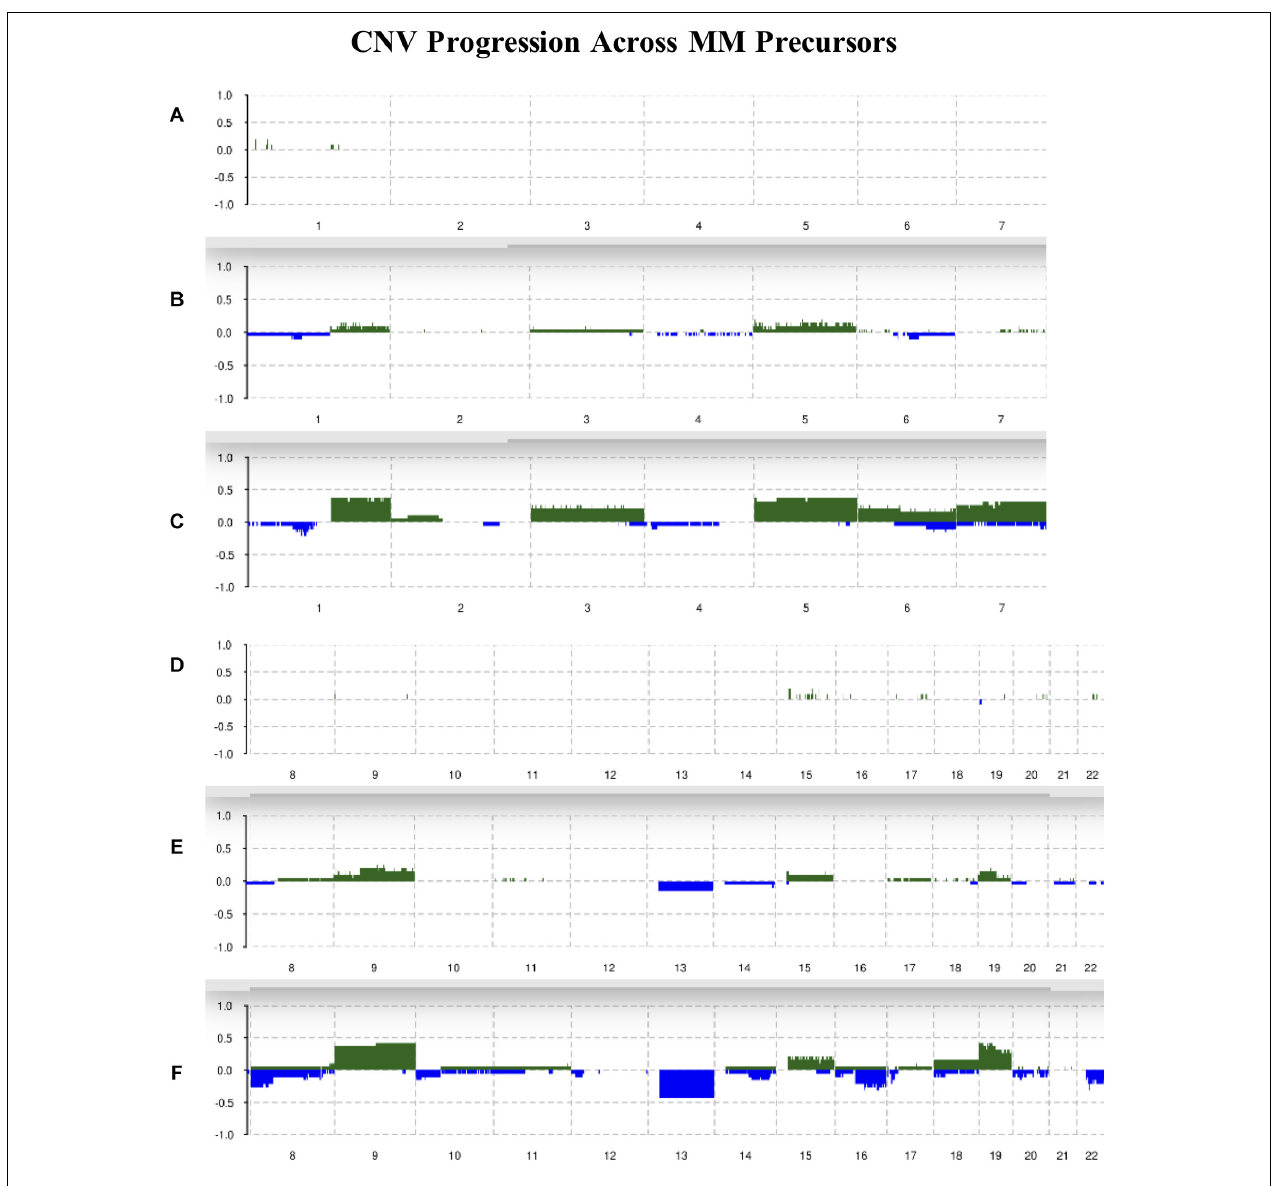
FIGURE 2 | Summary of CNVs across the genome from chromosomes 1–7 in (A) normal, (B) MGUS, and (C) SMM samples. Summary of CNVs across the genome from chromosomes 8–22 in (D) normal, (E) MGUS, and (F) SMM samples. The y -axis indicates the frequency of the chromosomal aberration. Green indicates amplification; blue indicates